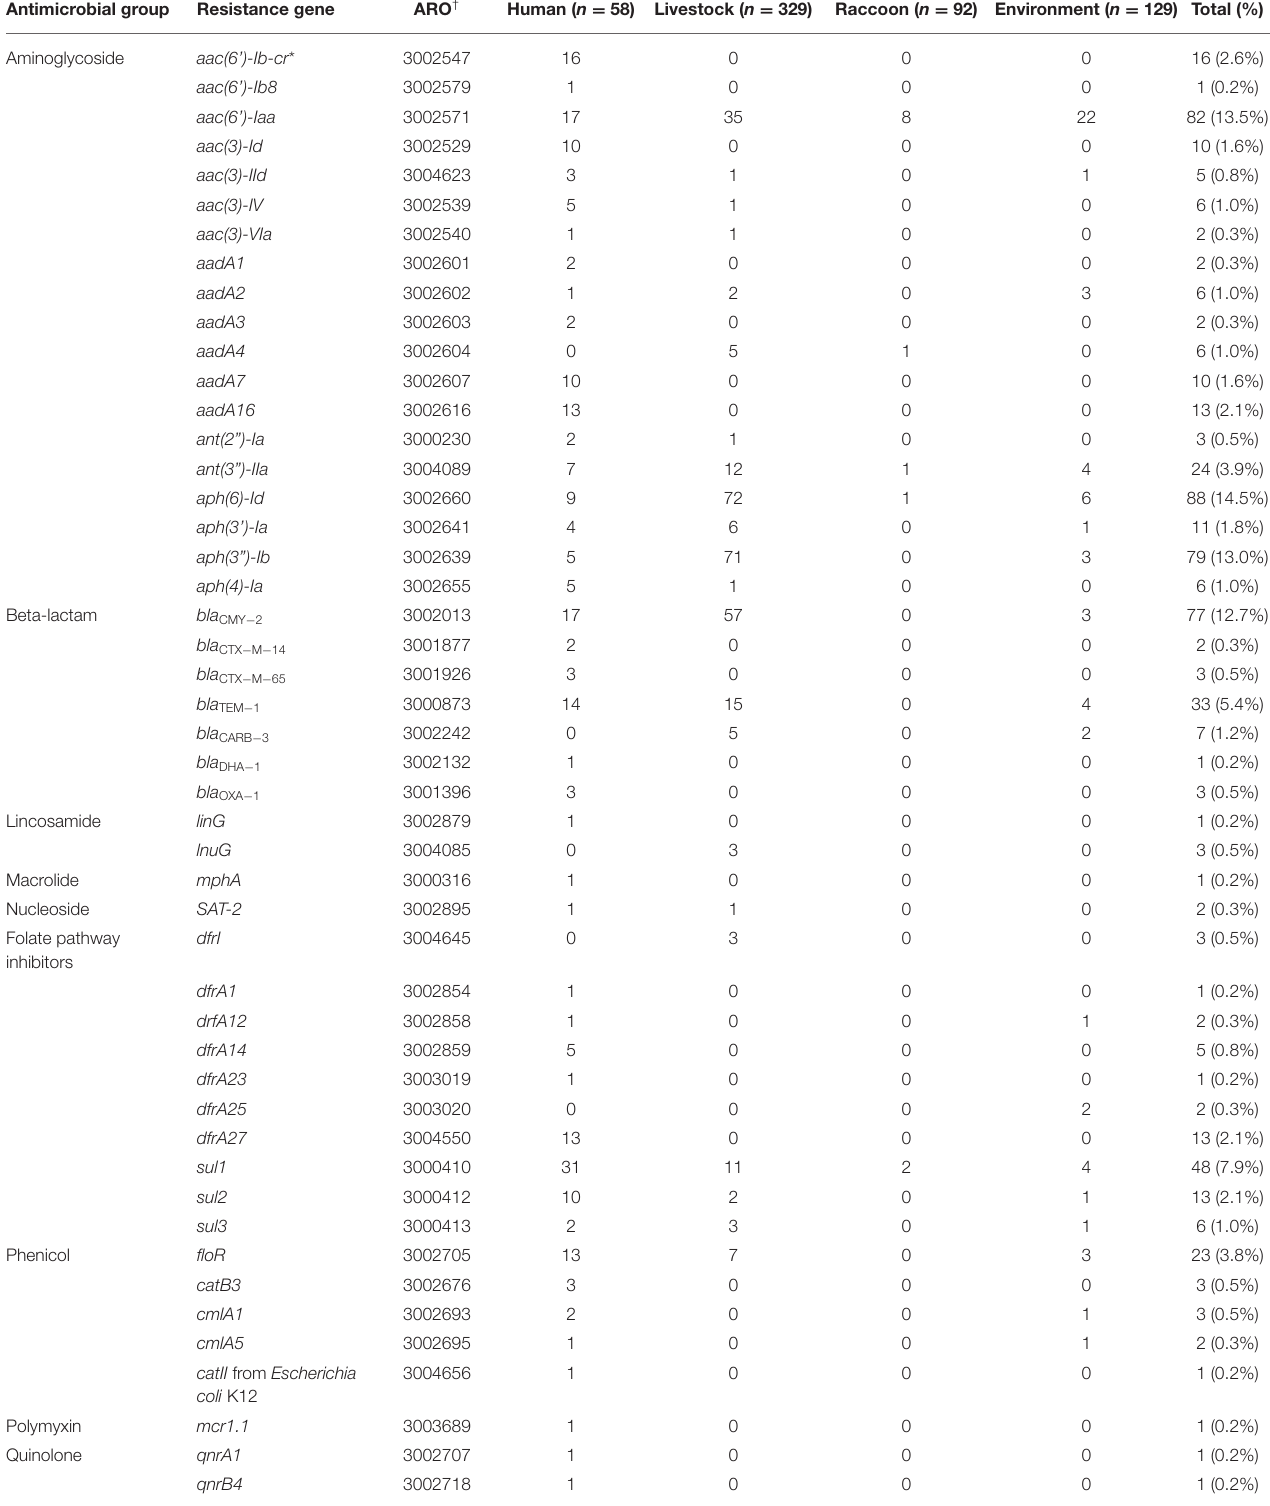
TABLE 3 | Frequencies of acquired antimicrobial resistance genes identified using whole-genome sequence data from Salmonella enterica isolates from raccoons, humans, livestock, and environmental sources in southern Ontario, Canada, 2011 – 2013 ( n = 608). Antimicrobial group Resistance